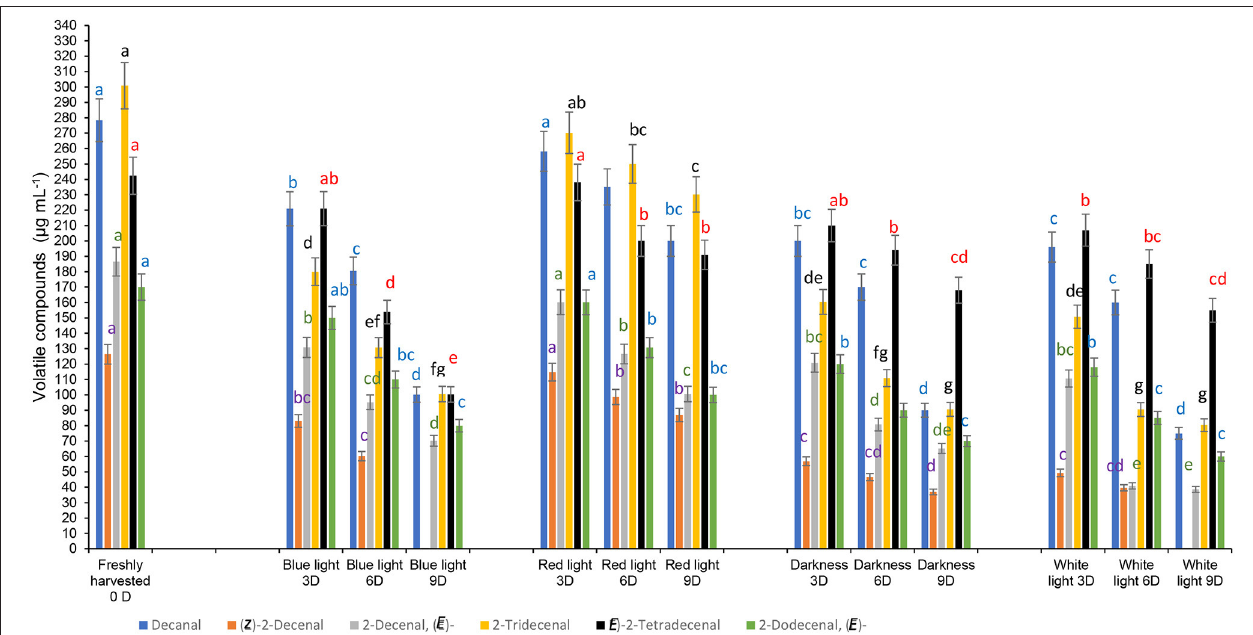
FIGURE 8 | Effect of blue and red LED light treatments on the changes in the concentrations of major volatile compounds in coriander ( Coriandrum sativum ) leaves. Different letters in the same bar indicate significant differences at p < 0.05 for a specific volatile compound.